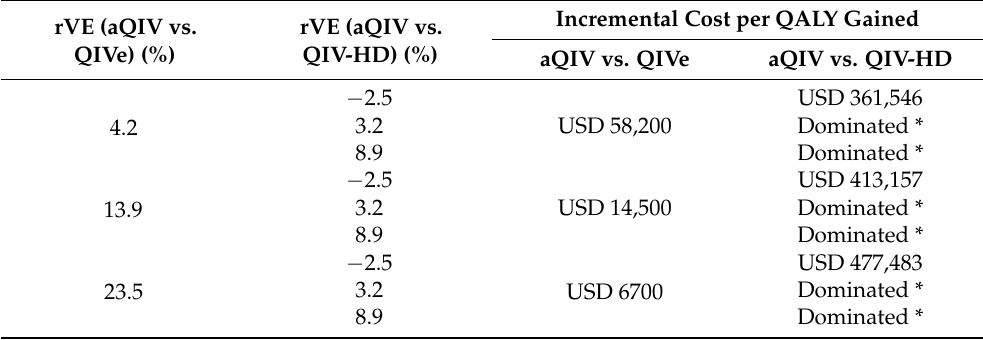
Table 6. Effectiveness scenario analyses: The impact of varying relative vaccine effectiveness on the cost-effectiveness of the enhanced vaccines (societal perspective). rVE (aQIV vs. rVE (aQIV QIVe) (%)